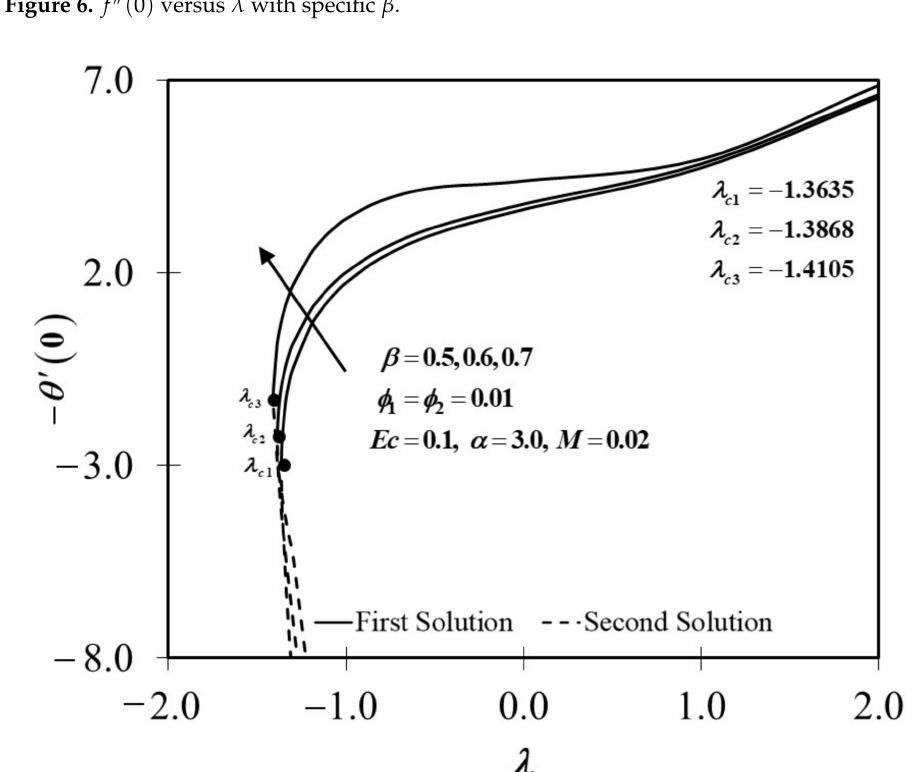
Figure 7. − θ (cid:48) ( 0 ) versus λ with specific β